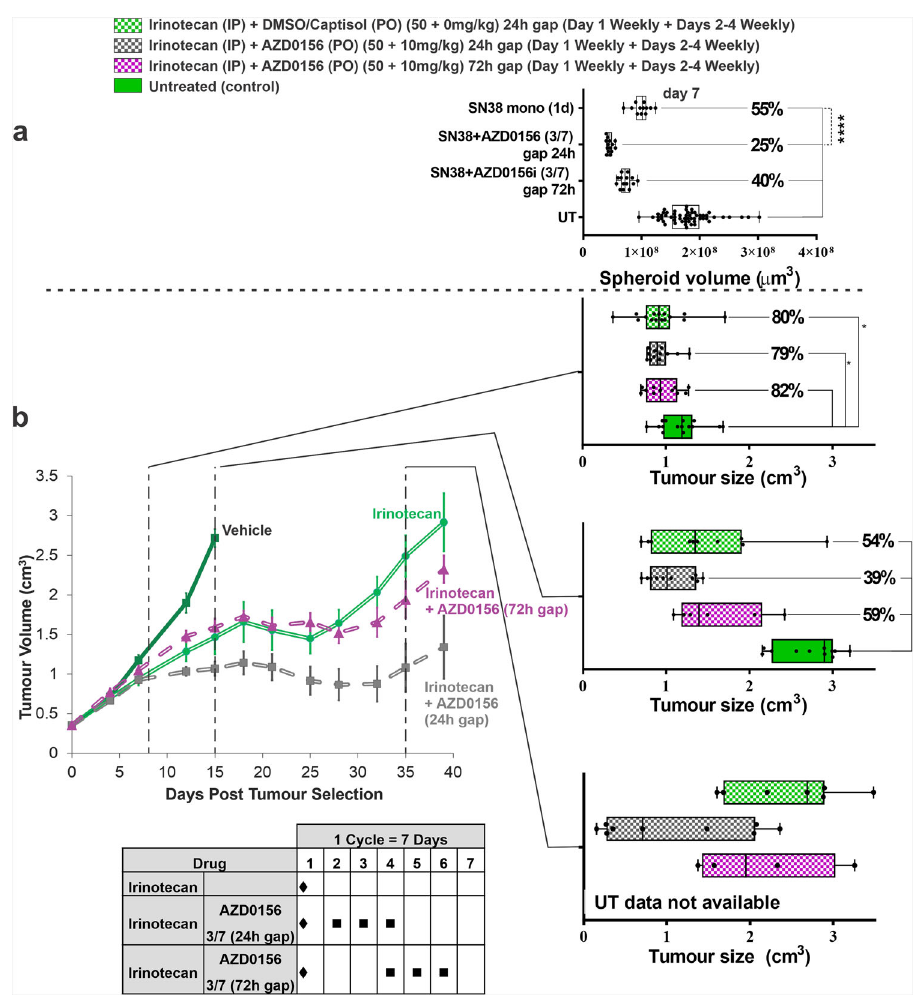
Fig. 5 Comparison of SW620 tumour cells response to different schedules of topoisomerase-I inhibitor and AZD0156 in the micro fl uidic Ibidi chip versus mouse in vivo study. SW620 tumour spheroids were treated with SN38 and two different gapped schedules with the ATM inhibitor in Ibidi micro fl uidic chip using 8-concentration pro fi le over 24 h (Table 1), spheroids volumes were evaluated at day 7 of post-treatment. N ≥ 5 per condition from two independent experiments. Box-plots show median (centre line); box limits are 25th to 75th percentile; whiskers represent min and max values ( a ); SW620 tumour xenografts were subcutaneously implanted in mice ( N = 15 per group) and subjected to the same treatment schedules as the spheroids in Ibidi chip. Tumour volume was measured regularly over 40 days. The graph represents mean ± SE. Tumour volumes at days 7, 15 and 35 were plotted as box-and-whisker graphs for easier comparison with in vitro micro fl uidic data (median — centre line; box limits — 25th to 75th percentile; whiskers — min and max values) ( b ). Statistical analysis was carried out using 1-way ANOVA, Tukey ’ s multiple comparisons, CI = 95%, **** p < 0.0001; *** p < 0.001; ** p < 0.01; * p <